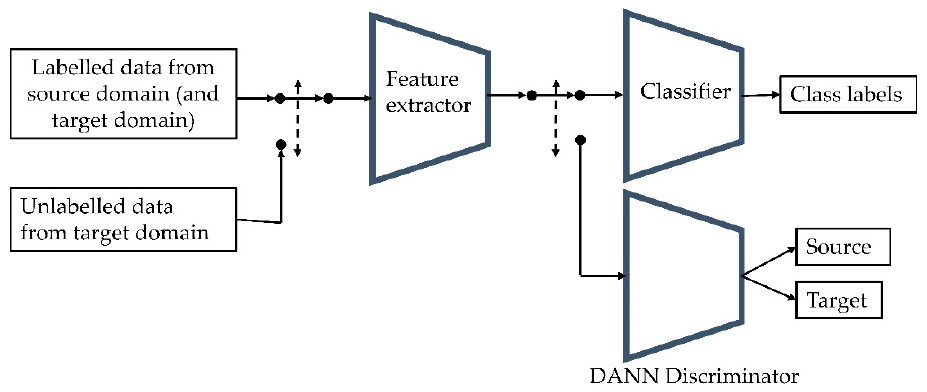
Figure 2. A diagram of the domain-adversarial neural network (DANN) structure and training procedure. The network was trained in three steps, iteratively: (1) the feature extractor and classifier were trained to classify the labelled data, (2) the discriminator module was trained to classify the domain of the labelled data and the feature extractor was trained to confuse the discriminator, (3) the discriminator module was trained to classify the domain of the unlabelled data and the feature extractor was trained to confuse the discriminator.